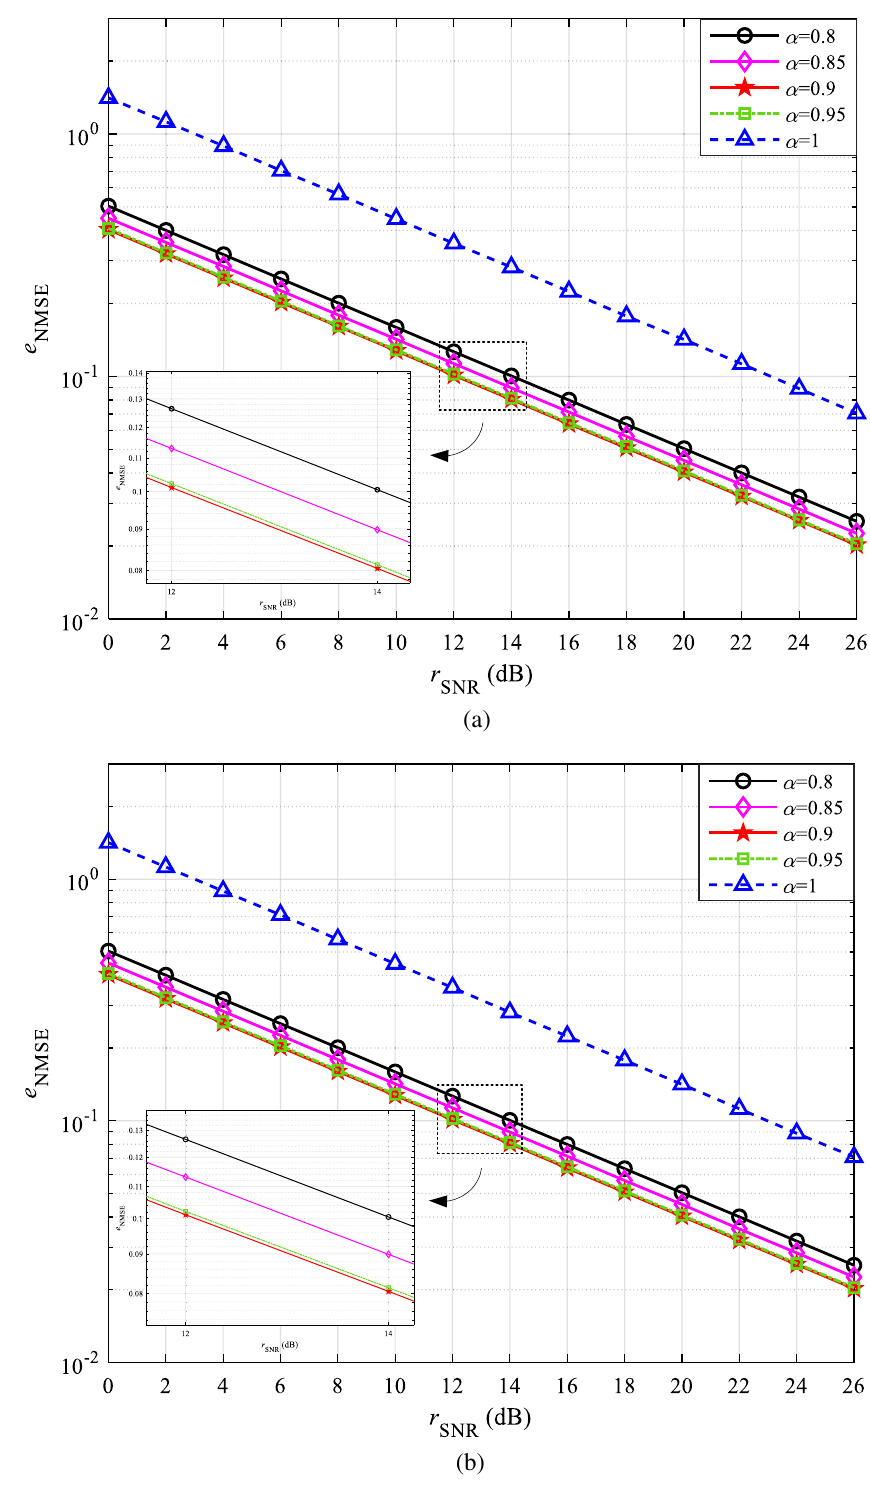
Figure 4. NMSE curves with α within 0.8 to 1: ( a ) CDT 1 and ( b ) CDT